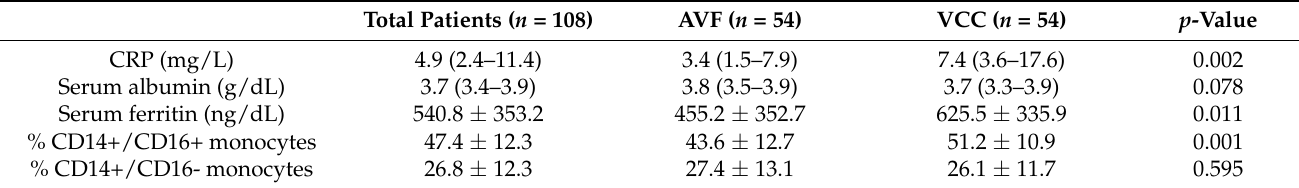
Table 2. Comparison between patients with AVF and VCC of the variables of inflammation and microinflammation. Total Patients ( n = 108) AVF ( n = 54) VCC ( n = 54) p -Value CRP